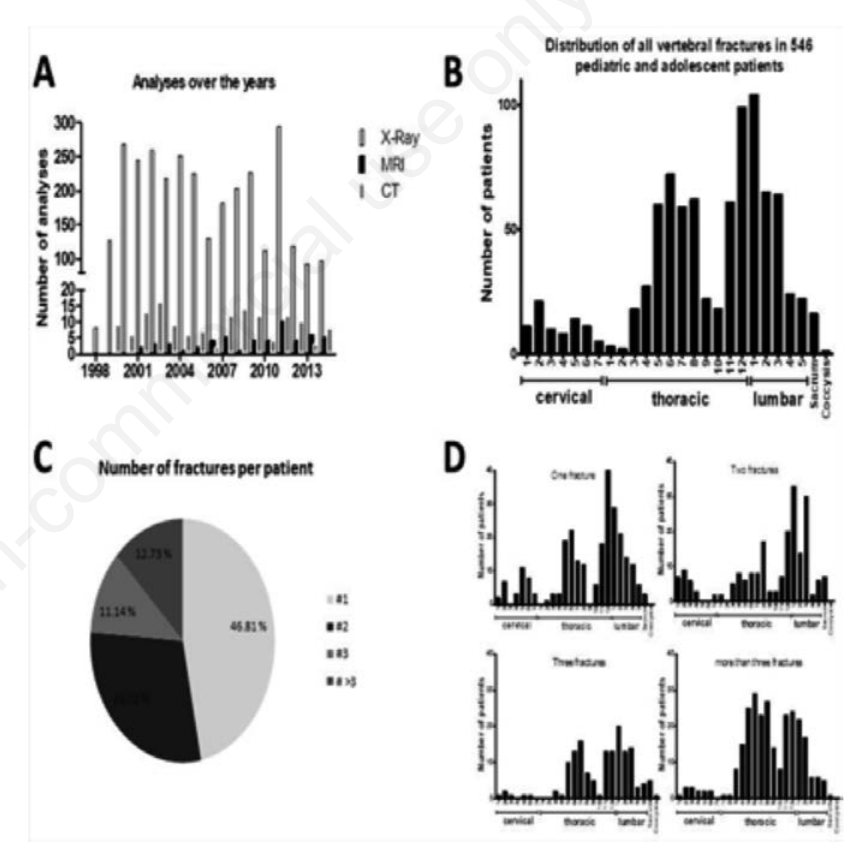
Figure 1. The number of X-rays, CT scans and MRIs performed from 1998 to 2014 (A). The use of di-agnostic tools reveals a slight increase in the number of MRI scans in the past several years, whereas X-rays were used more and more sparingly. The distribution of vertebral fractures in all 546 pediatric and adolescent patients (B). The localization of fractures was observed, and the distribution revealed a thoracolumbar peak. Number of fractures per patient (C). The number of fractures per patient was determined. Less than half of all fractures occurred as single fractures (206), and most children exhibited more than one fracture (129 had two fractures, 49 had three fractures, and 56 had more than three fractures). The Distribution of fractures (D) in 206 patients with one fracture exhibits a lumbar peak, while the 129 patients with two fractures show a shift to the tho- racic spine. In the three fractures group of 49 patients, the thoracic spine-shift is contin- ued while in 57 patients with more than three fractures, the peak in the thoracic